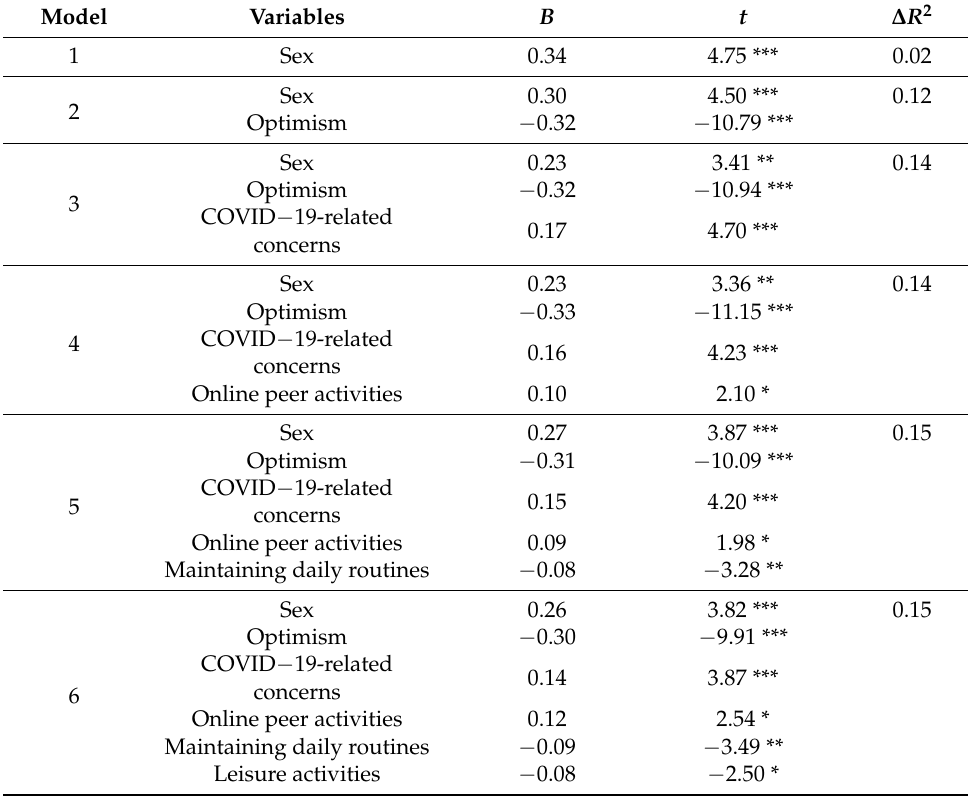
Table 4. Results of the multiple linear regression on adolescents’